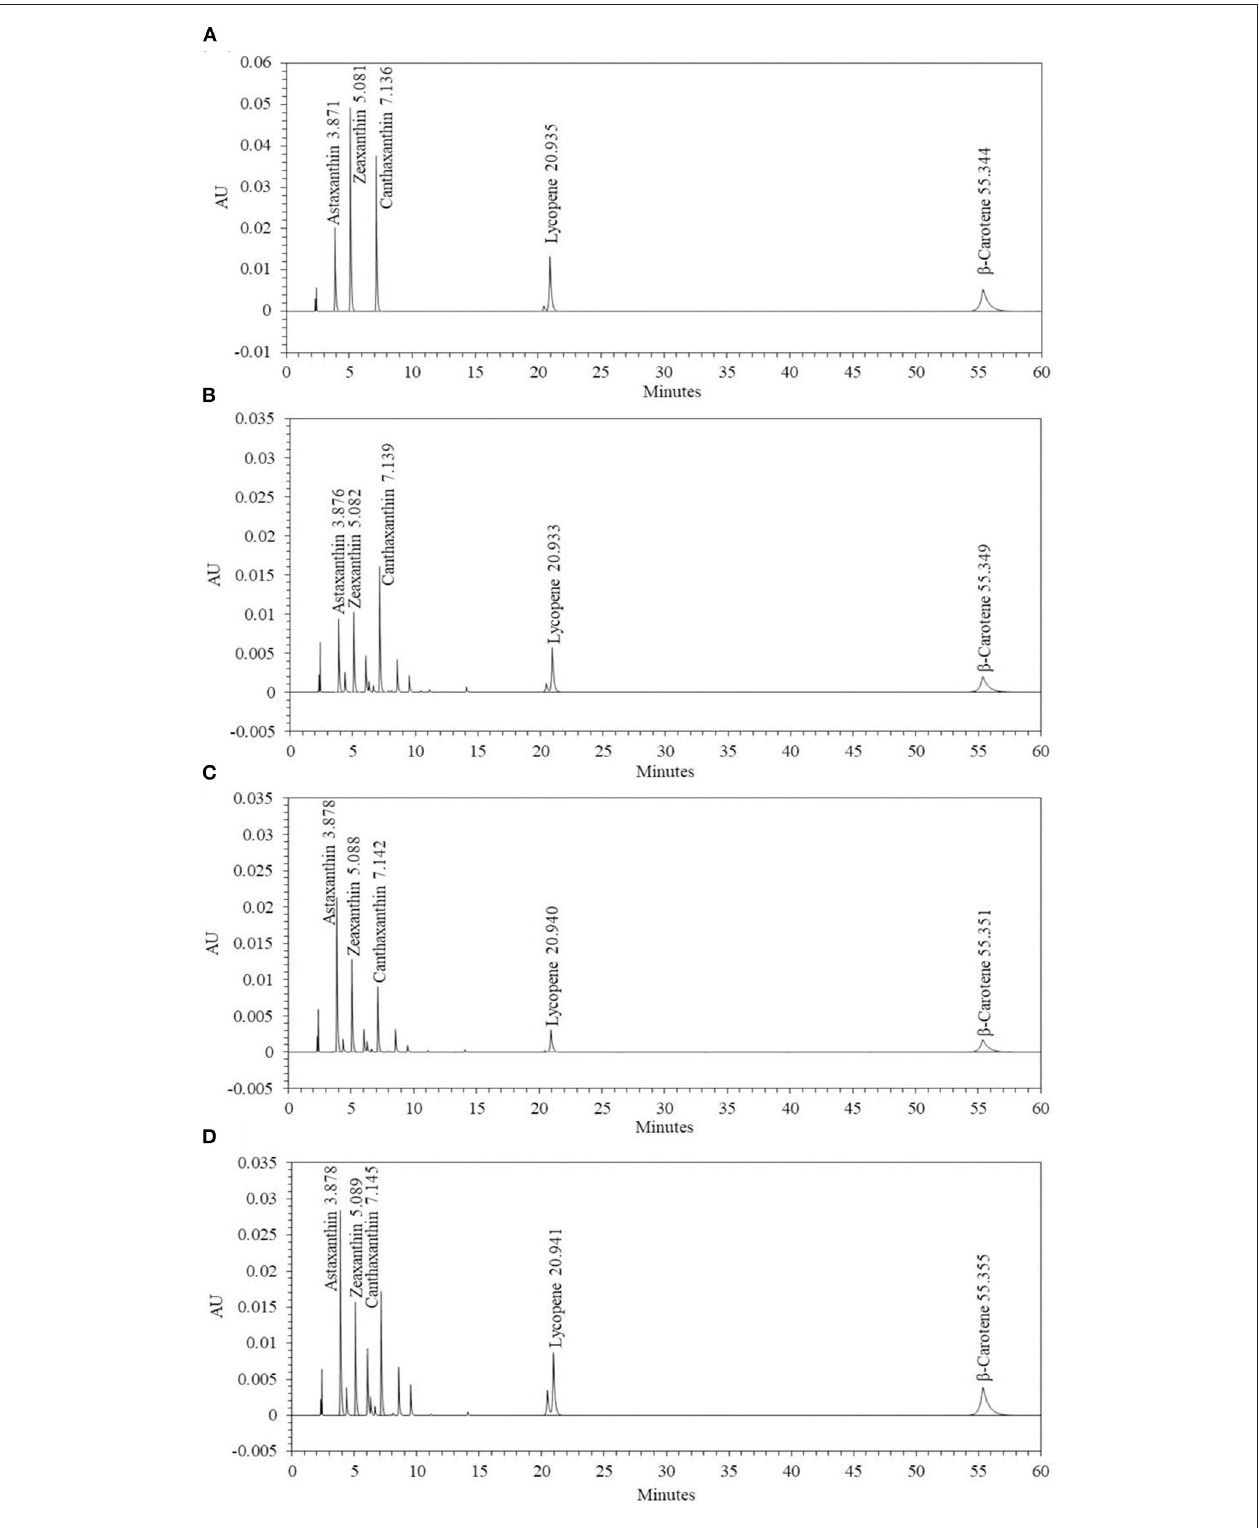
FIGURE 6 | High performance liquid chromatography chromatograms of the carotenoids extracted from Paracoccus haeundaensis and the co-culture with Lactobacillus fermentum . (A) Standard carotenoids, (B) P. haeundaensis cultured in the LB medium, (C) P. haeundaensis cultured in the PMF medium, (D) co-culture of P. haeundaensis and L. fermentum in the PMF